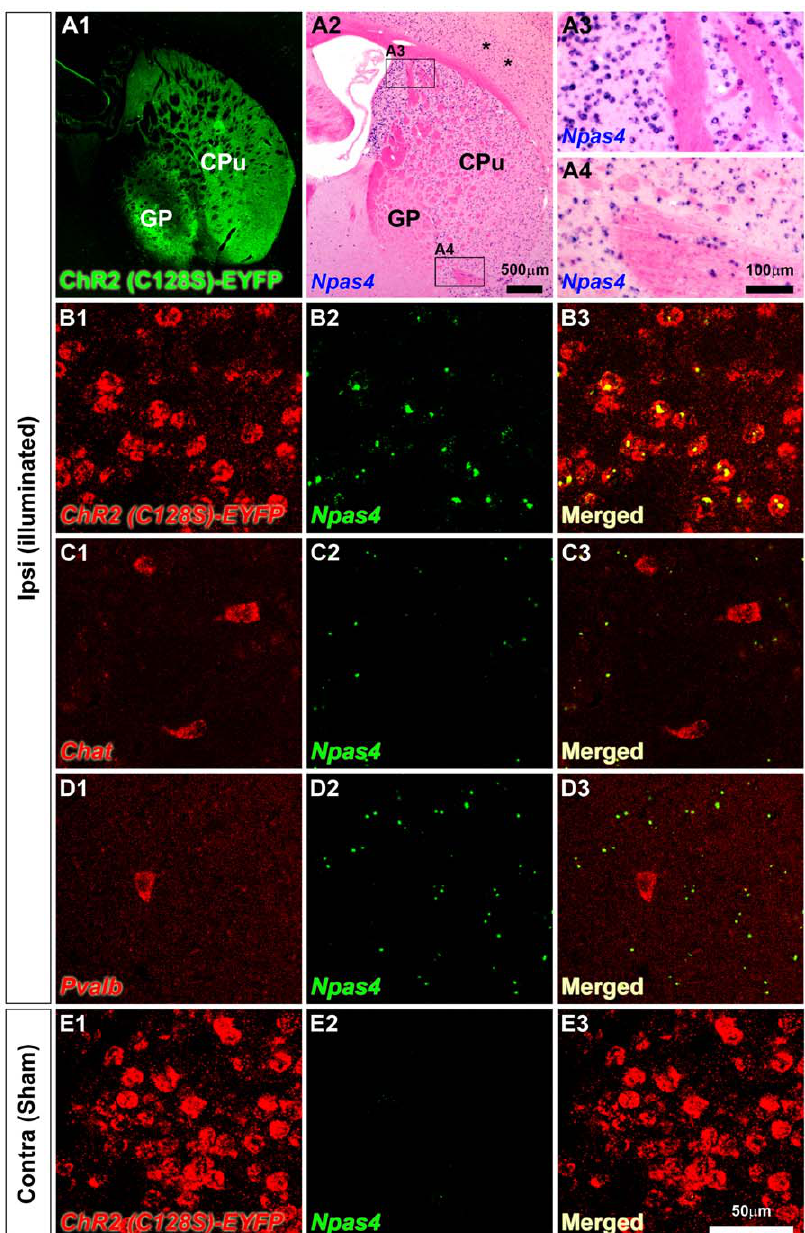
Figure 5. Optical stimulation-induced Npas4 expression was mostly limited to the ChR2(C128S) expressing MSNs. (A1) A representative fluorescent image of coronal tissue sections indicates strong expression of the transgene ( ChR2(C128S)-EYFP ) in the striatum. (A2) After unilateral light stimulation Npas4 mRNA expression was induced in the ipsilateral striatum (CPu, Caudate putamen). Note that Npas4 induction was also observed in the cerebral cortex in some cases (asterisks, A2). Boxed areas in A2 are shown in higher magnification in A3 and A4. Induction of Npas4 was observed from the dorsal (A3) to the ventral (A4) striatum. (B1–B3) Most of the striatal MSNs expressed the transgene ChR2(C128S)-EYFP (B1, red). After illumination Npas4 (green) was expressed in the ipsilateral striatum (B2). Almost all Npas4 -expressing cells were co-labeled with ChR2(C128S)-EYFP (B3). (C1–C3) Cholinergic interneurons were identified by Chat expression (C1, red). There was almost no co-labeling for Npas4 (green) and Chat (red) (C2, C3). (D1–D3) Npas4 (green) mRNA expression was not induced in Pvalb (red)-positive GABAergic interneurons. (E1–E3) Strong expression of ChR2(C128S)-EYFP (red) was observed in the contralateral sham-treated striatum (E1, E3) where Npas4 (green) expression was almost absent (E2, E3). CPu, Caudate putamen; GP, Globus pallidus. Scale bars: (A1, A2) 500 m m, (A3, A4) 100 m m, (B1–E3) 50 m m.